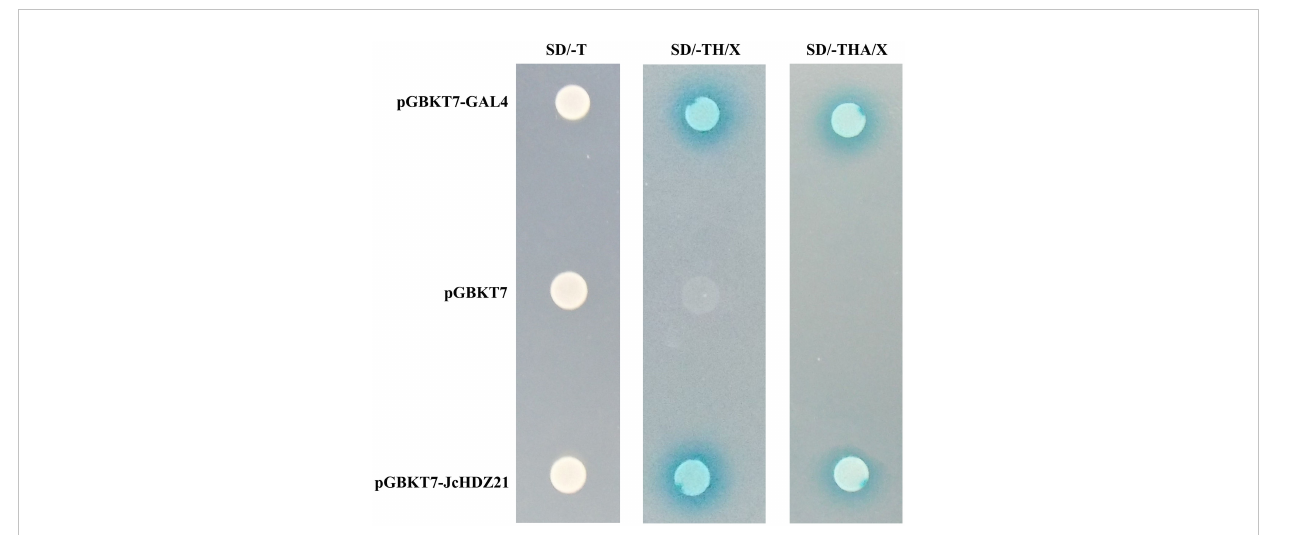
FIGURE 4 JcHDZ21 protein transcriptional activity. The left panel shows pGBKT7-GAL4, pGBKT7 and pGBKT7-JcHDZ21 grown on SD/-Trp plates for 4d, and the middle panel shows pGBKT7-GAL4, pGBKT7 and pGBKT7-JcHDZ21 grown on SD/-Trp/-His/X-a-gal plates for 4d, and the right panel shows pGBKT7-GAL4, pGBKT7 and pGBKT7-JcHDZ21 grown on SD/-Trp/-His/-Ade/X-a-gal plates for